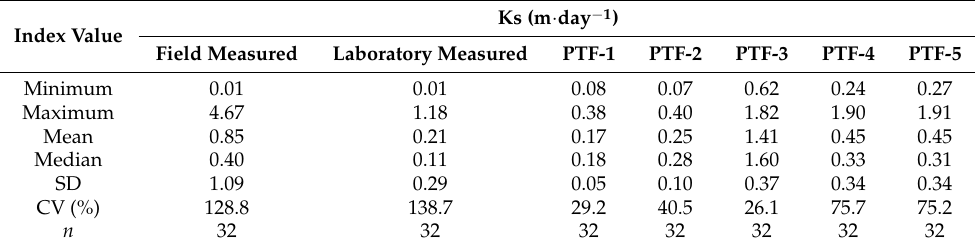
Table 5. Basic descriptive statistics for soil hydraulic conductivity (Ks) for topsoils and subsoils.